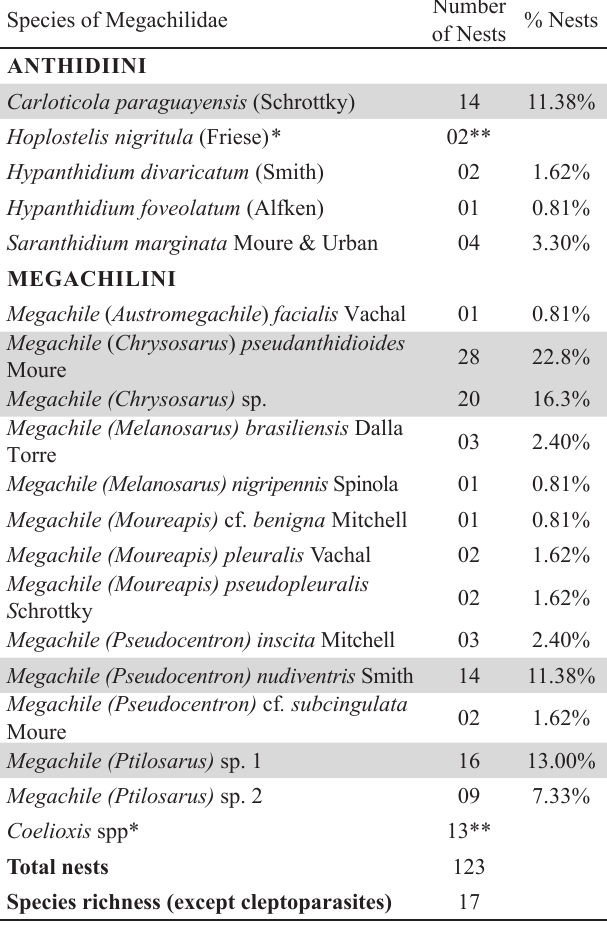
Table 1 . Number of nests of Megachilidae constructed in trap-nests in a remnant of the Atlantic Forest in Brazil (União Biological Reserve, RJ, Brazil). The five most abundant species are highlighted. *cleptoparasites ; **number of nests where respective cleptoparasites emerged.